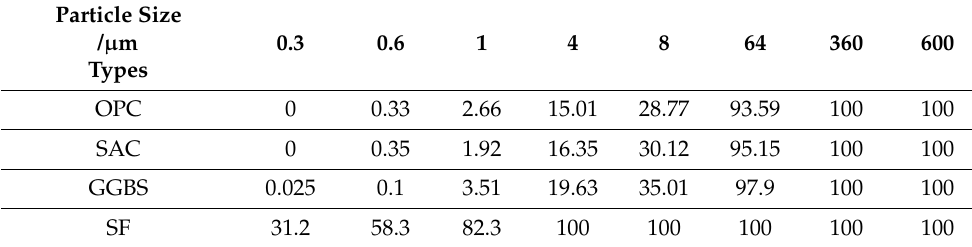
Table 1. Particle passing percentage of the cementitious materials/%.